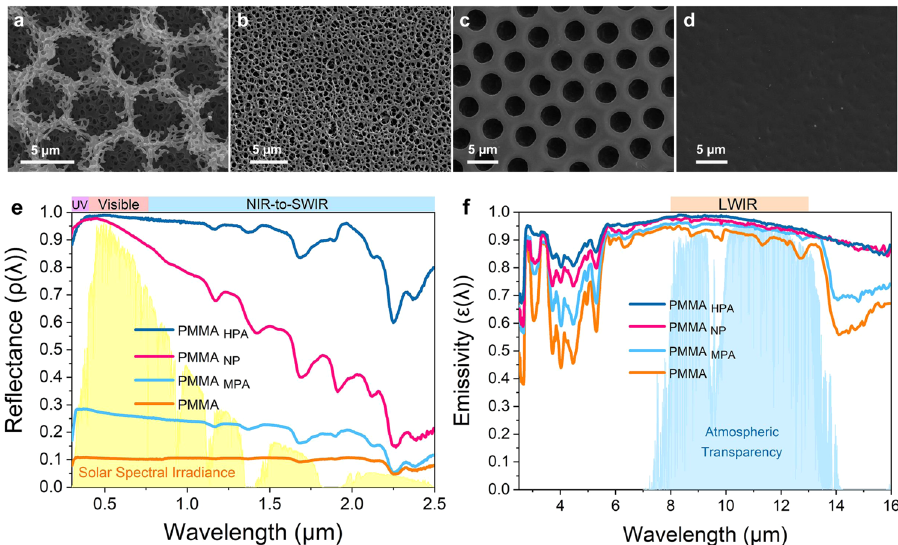
Fig. 4 SEM micrographs and optical properties of different types of PMMA fi lms. a – d SEM micrographs of the PMMA HPA , PMMA NP , PMMA MPA , and pristine PMMA fi lms. e Re fl ectance spectra across the solar wavelengths of different types of PMMA fi lms. f Infrared emissivity spectra of different types of PMMA fi